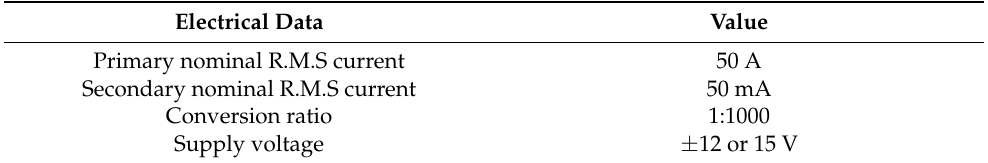
Table 1. LA 55-P sensor characteristics [35].